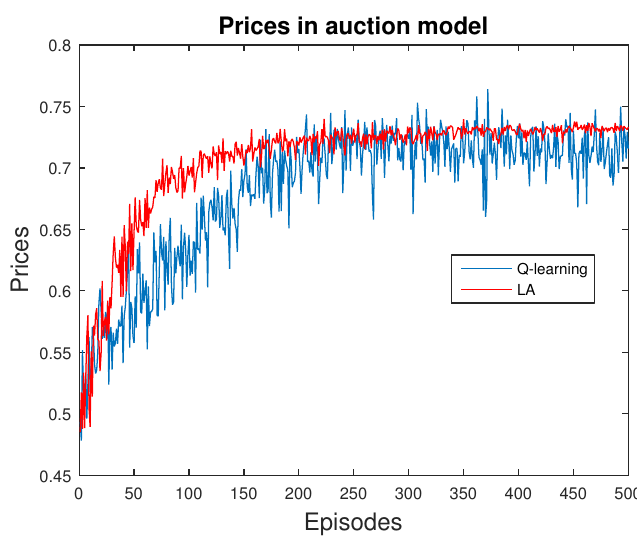
Figure 8. Price in this market. The results are similar to mathematical values.